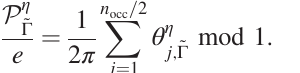
FIG. 4. Possible Wilson spectra along